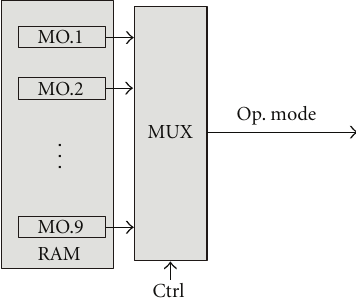
Figure 14: Block diagram of the control block in the